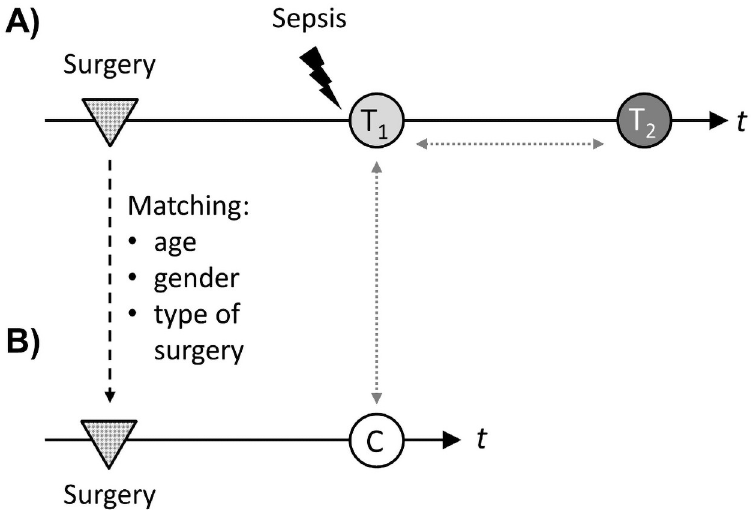
Fig 1. Study design. (A) Nine patients with sepsis after major abdominal surgery were included. Blood samples for experimental workflow were taken within 24h after diagnosis of sepsis (light grey circle, “T1”) and 7 days thereafter (dark grey circle, “T2”). Time (t) between surgery (grey dotted triangles) and sepsis diagnosis was recorded. (B) Control patients were identified by matching for age, gender and type of surgery. Seven days after surgery, blood samples were taken for experimental workflow (white circle, “c”). Comparisons were performed between control patients and patients with sepsis at T1, as well as between T1 and T2 in the cohort of sepsis patients (grey dotted